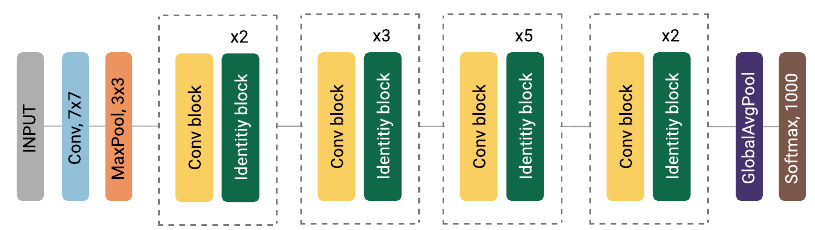
Figure 7. ResNet50